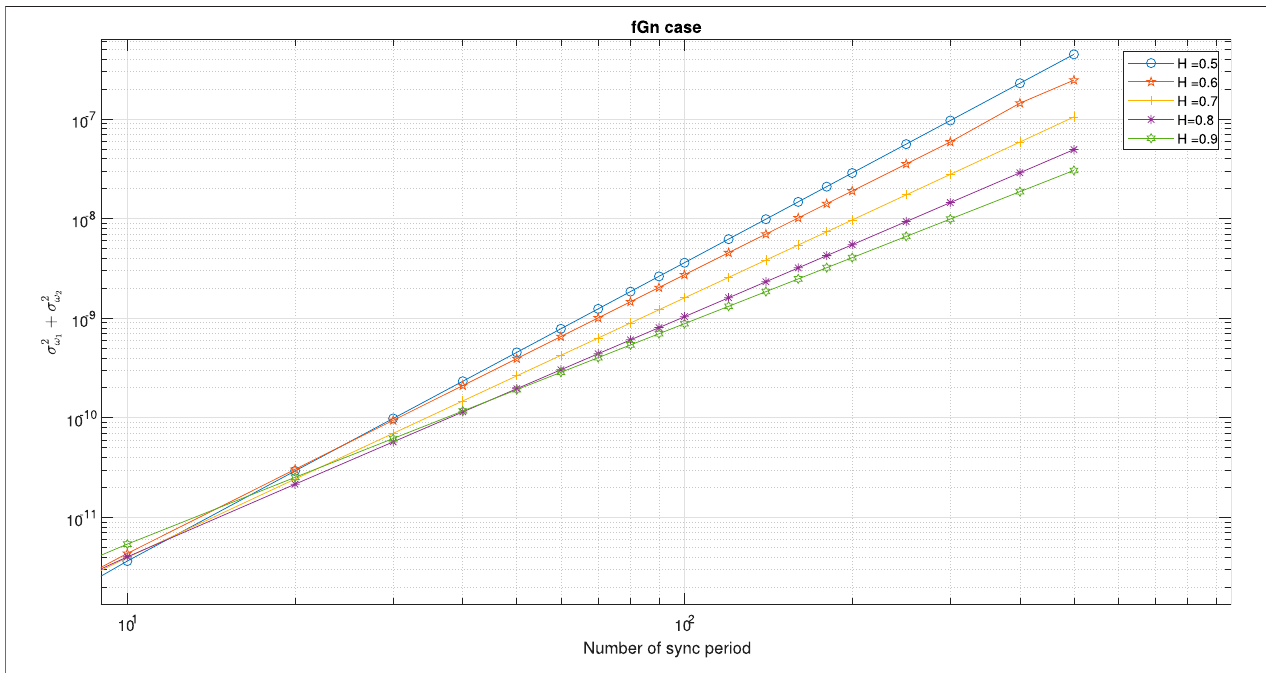
) and E [ e 2 ] (cid:1) 10 – 12 . sec